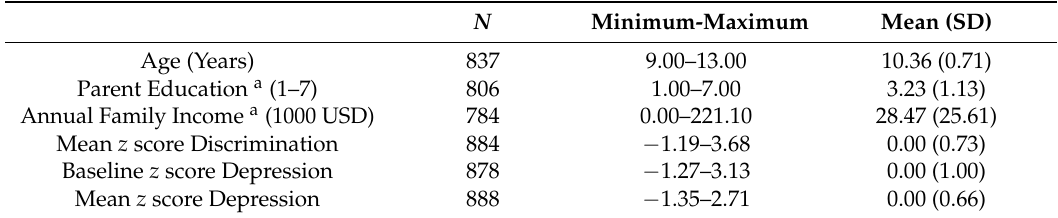
Table 1. Descriptive statistics in the pooled sample ( n =